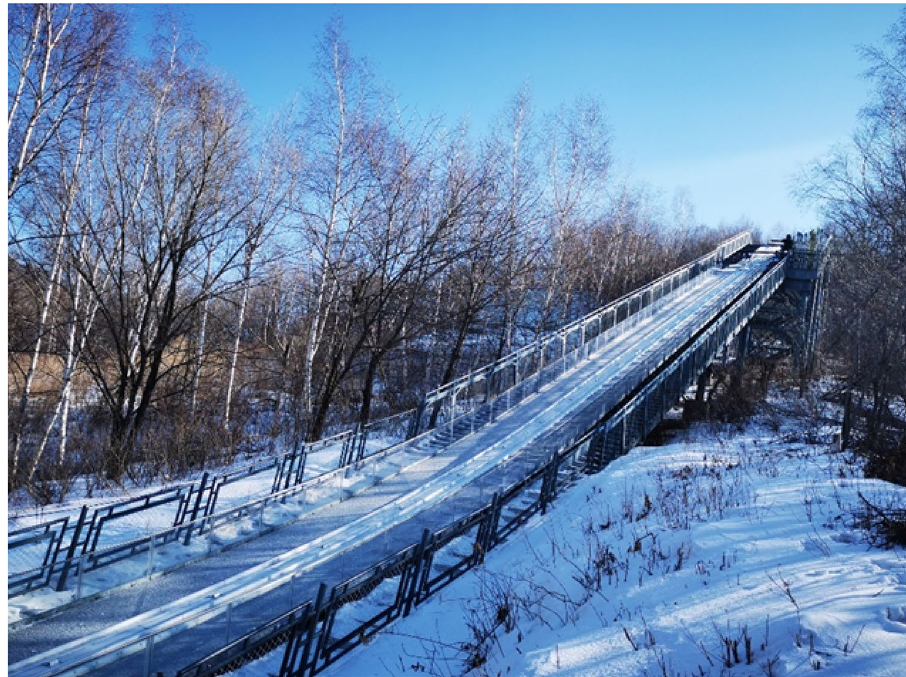
Figure 1. Panoramic view of the race track.